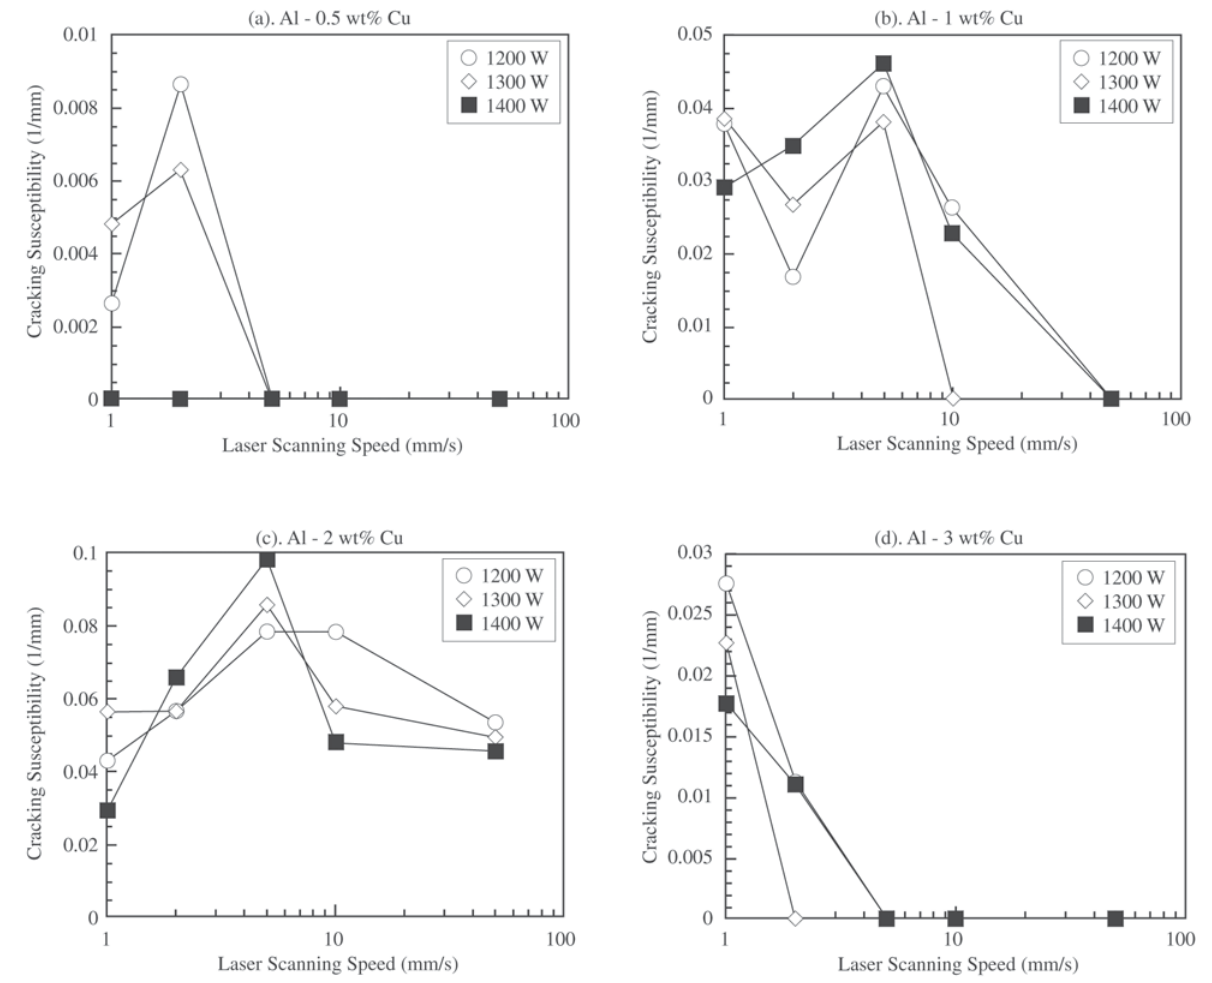
Figure 4. Cracking susceptibility of each alloy as a function of laser scanning